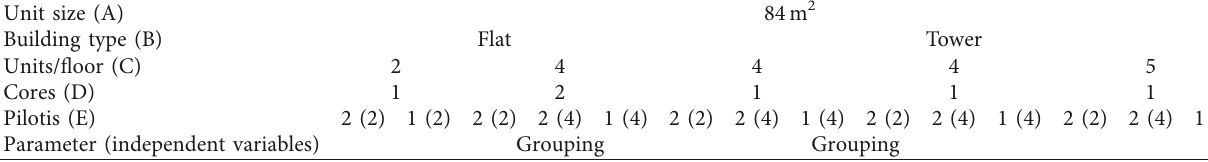
Figure 3: Tree structure for concept of case classification. Table 3: Data grouping by influential factors (e.g., 84m 2 group).